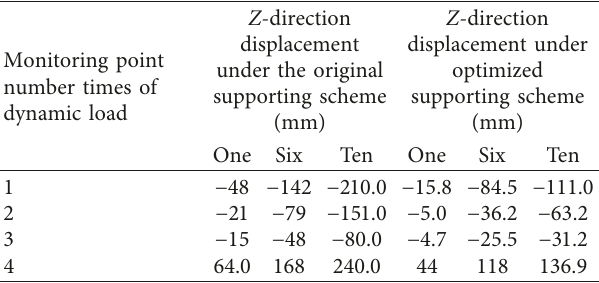
Table 4: Z -direction displacements for one, six, and ten dynamic loads.